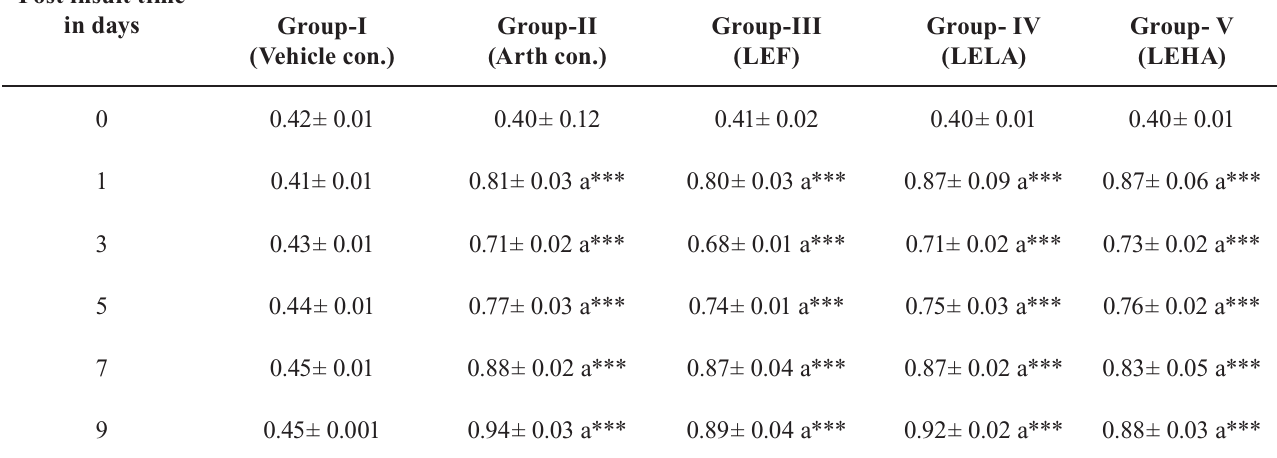
TABLE II- E ffect of leflunomide and amitriptyline against Freund’s complete adjuvant induced paw edema on ipselateral